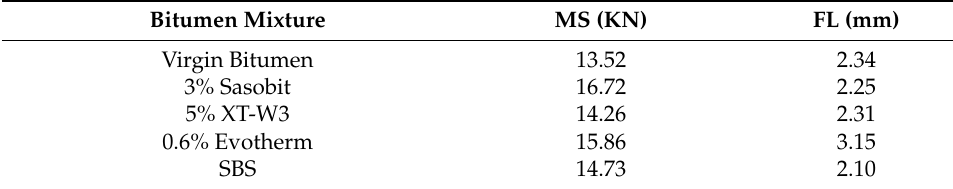
Table 6. Results of the Marshall stability